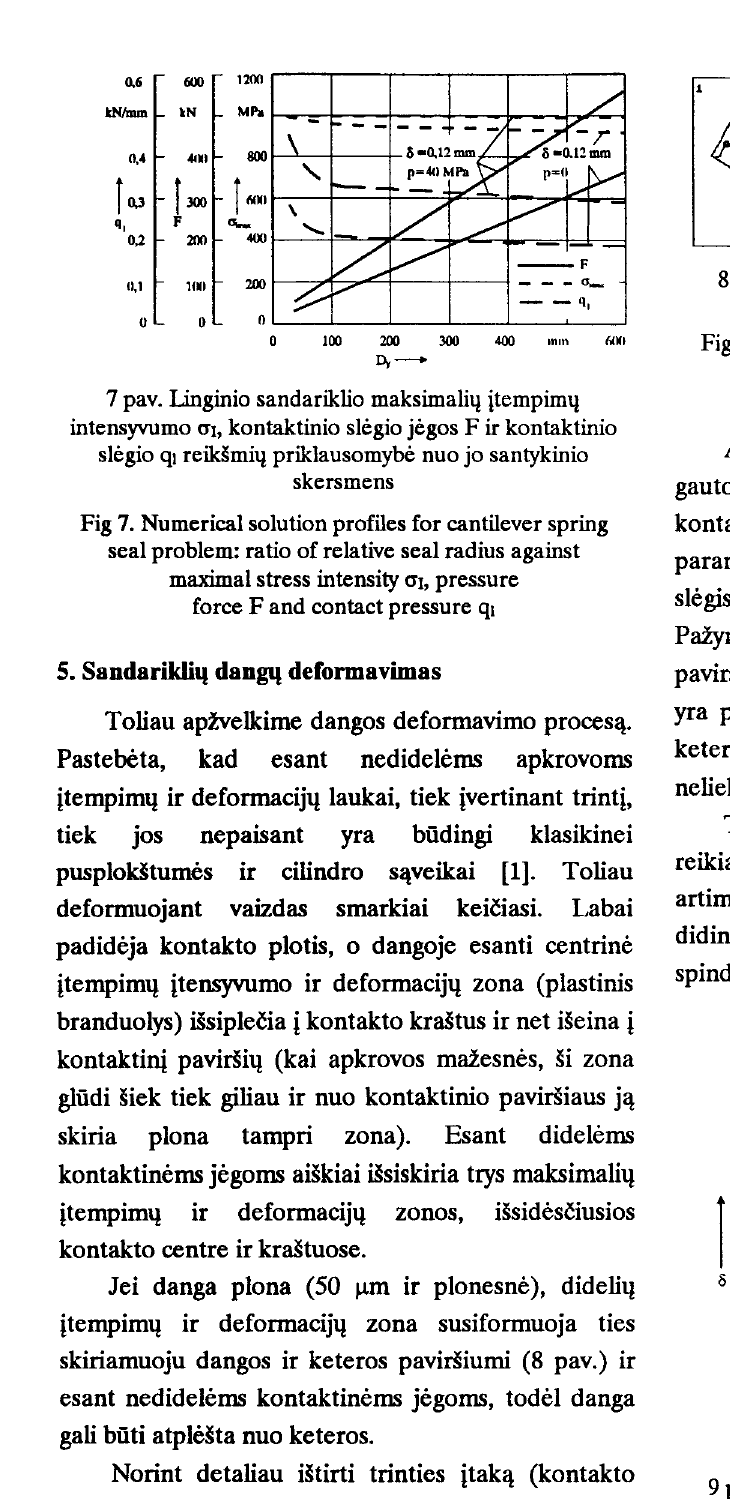
Fig 9. Numerical solution profiles for seals coating problem: ratio contact with against approach off contact surfaces a, relative contact force Fk and relation q/cr., when coating thickness is 0,14 mm and radius of indenter 0,5